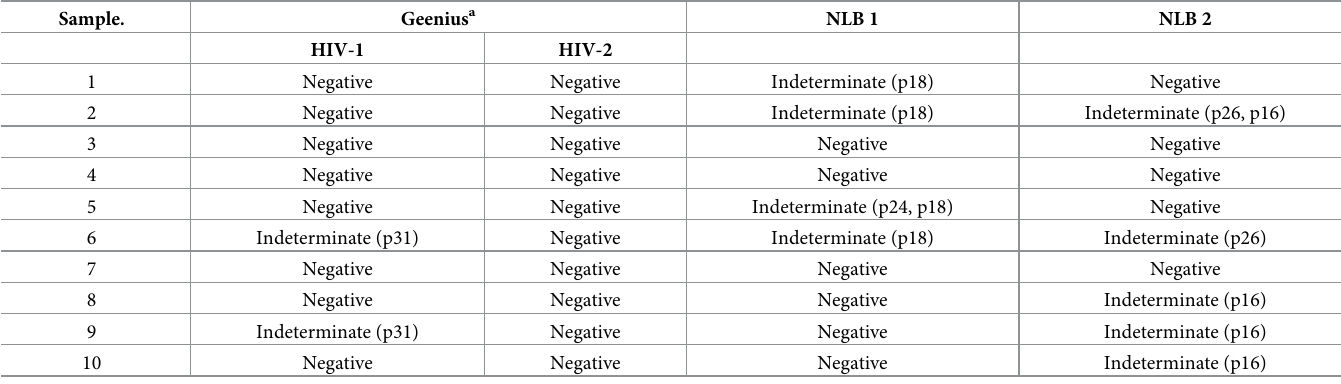
Table 5. Comparison of Geenius with NLB 1 and 2 results for HIV-1 Combo positive but NAT negative samples ( n = 10) a .